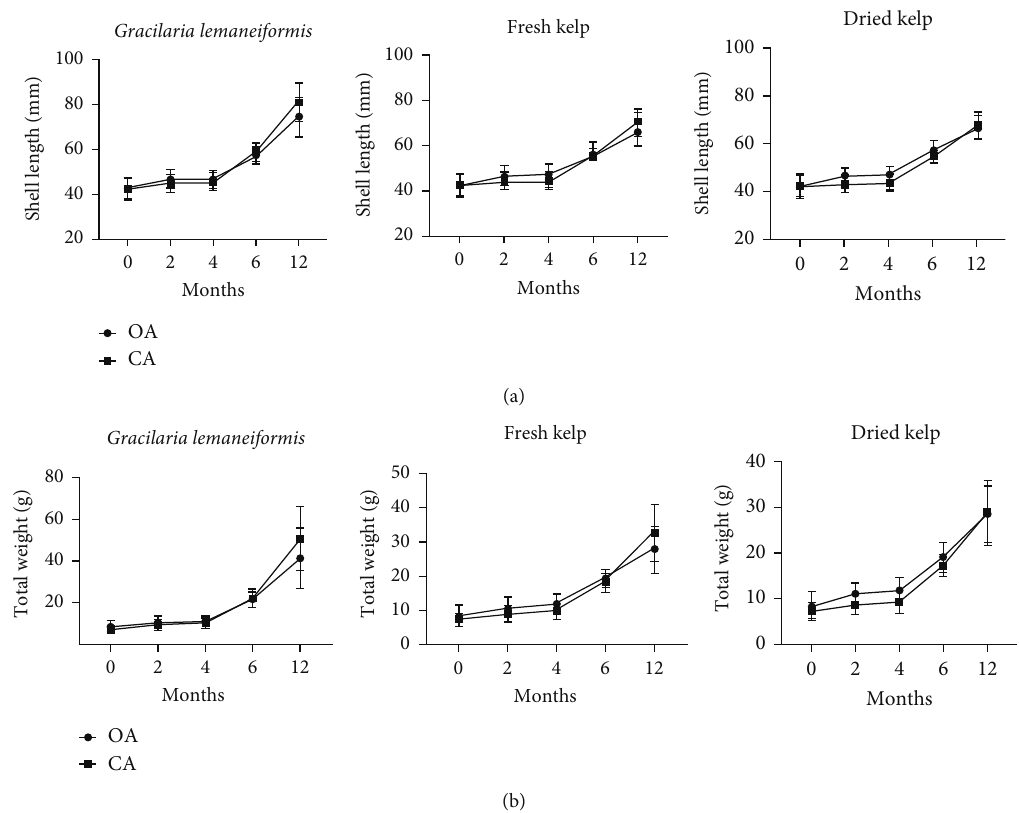
Figure 4: Changes in the growth traits of H. gigantea with di ff erent colors under various diets for 12